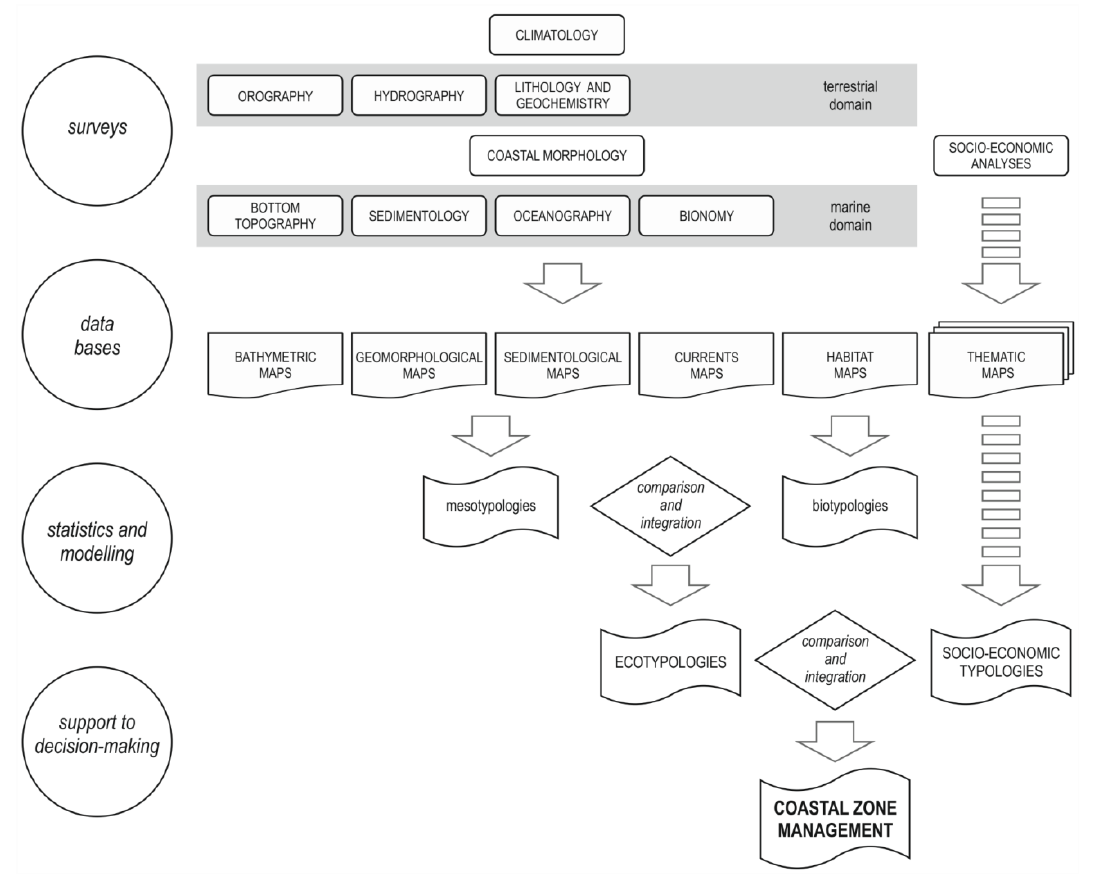
Figure 11. Scheme of the procedure for coupling ecological and